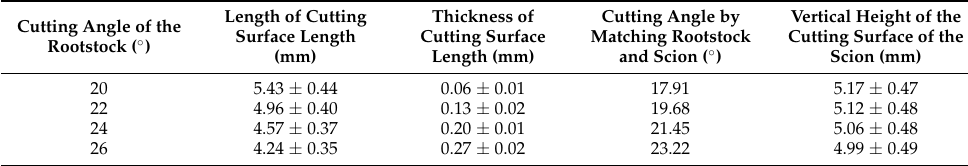
Table 4. Matching results of rootstock and scion after